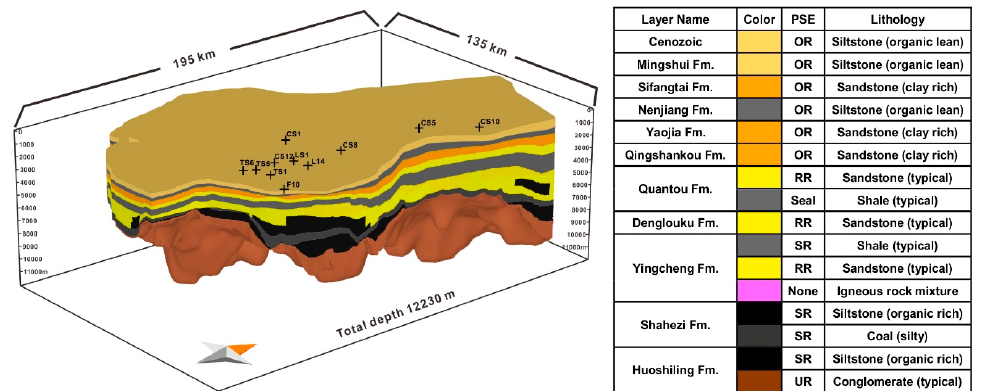
Figure 3. 3D model view and present-day dimensions of the Changling Depression. The table describes the general stratigraphy, alongside the PSE and the lithology types that were assigned for the model. Fm. = formation, OR = overburden rock, UR = underburden rock. “Igneous rock mixture” represents a mix of rhyolite, tuff and granite.